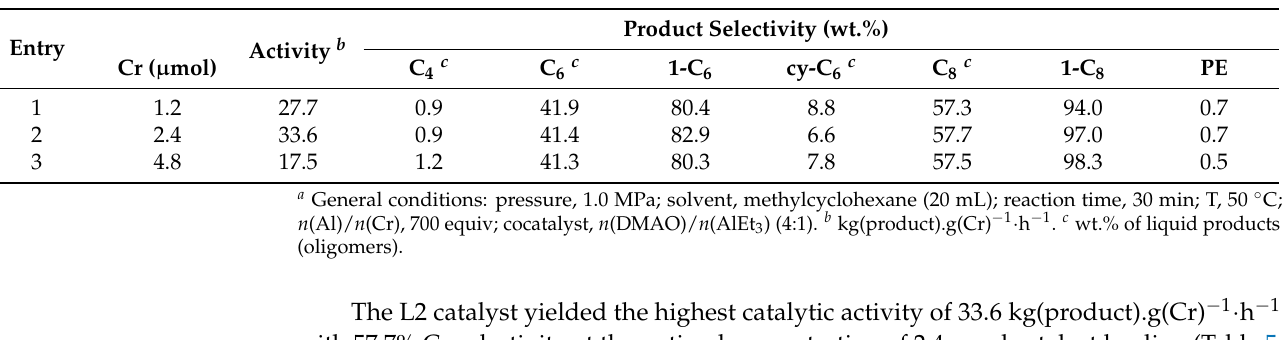
Table 5. The effect of catalyst loading on the catalytic performance of the L2-based catalyst a